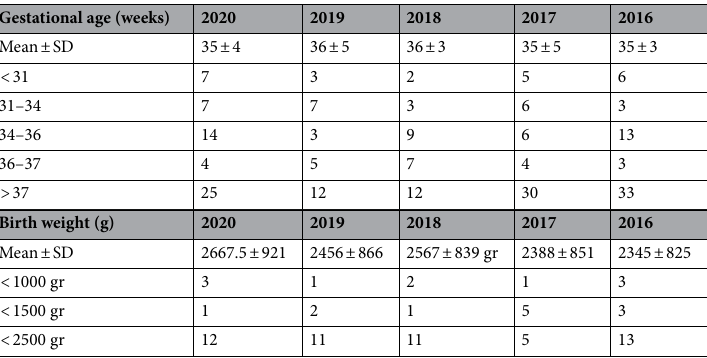
Table 1. Gestational age (GA) (a), birthweight (b) of patients transferred during